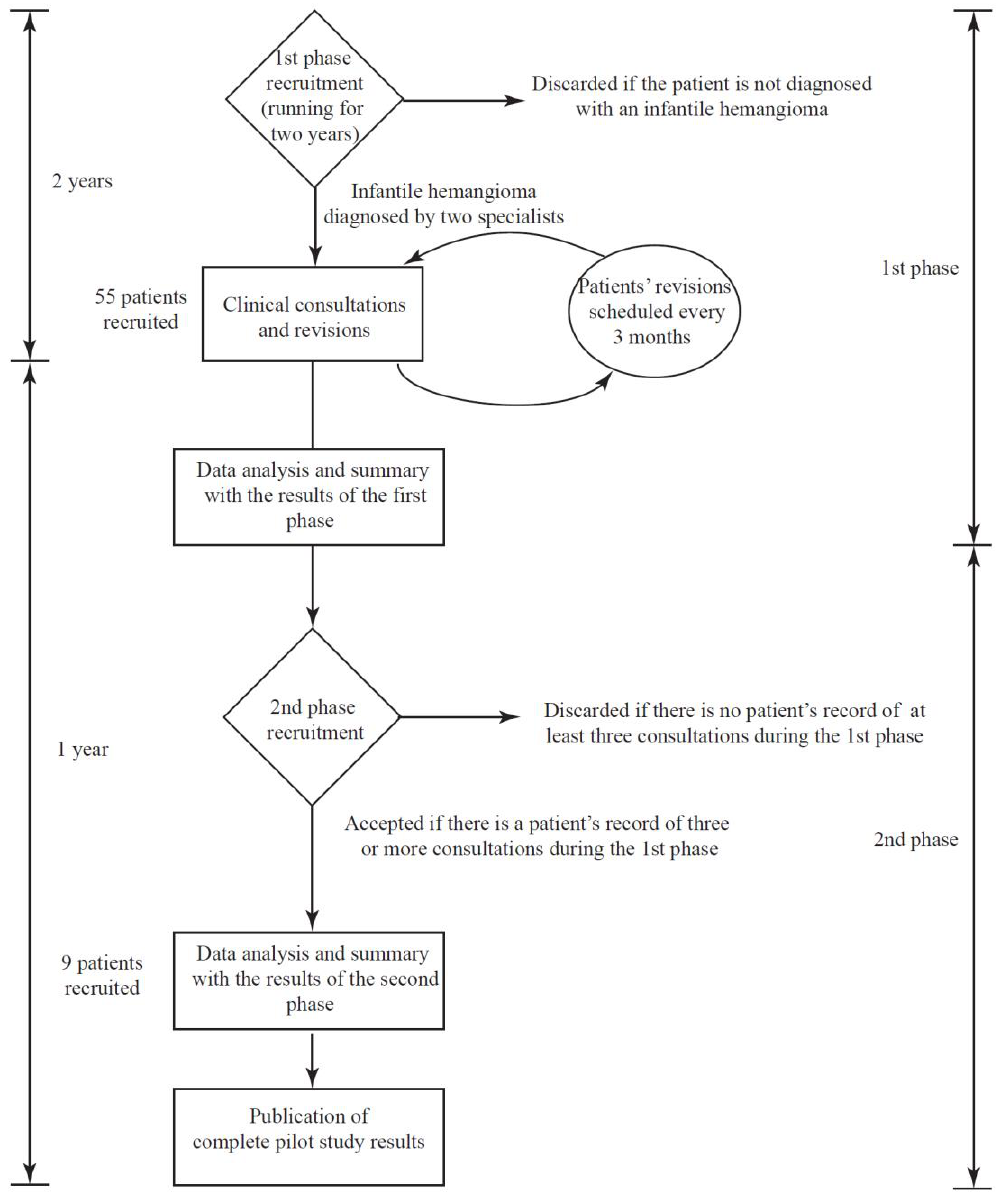
Figure 2. Flow chart summarizing the different steps and phases involved in the pilot study.